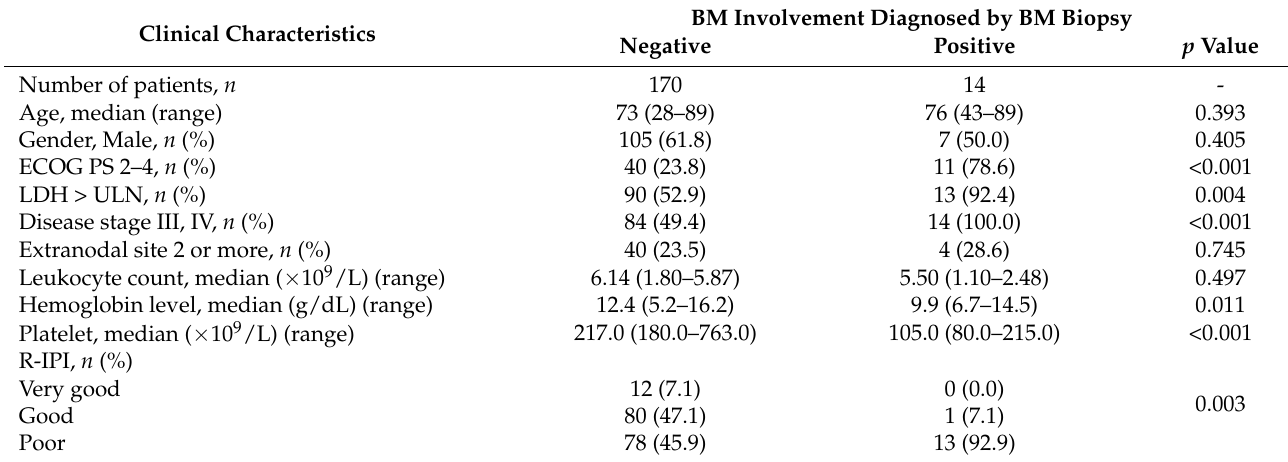
Table 3. Clinical characteristics of 184 patients treated with R-CHOP (-like) regimen in association with BM involvement detected by BM biopsy.